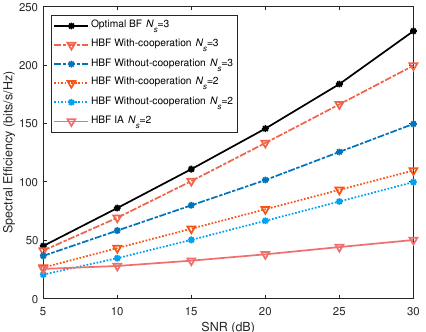
Figure 3. Effective system sum rate versus